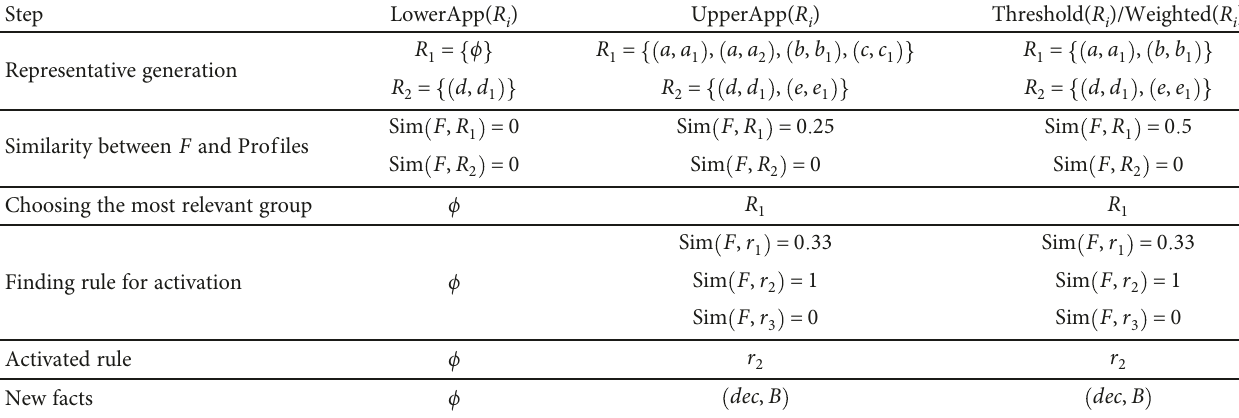
Table 1: The course of knowledge exploration for an example of knowledge base.